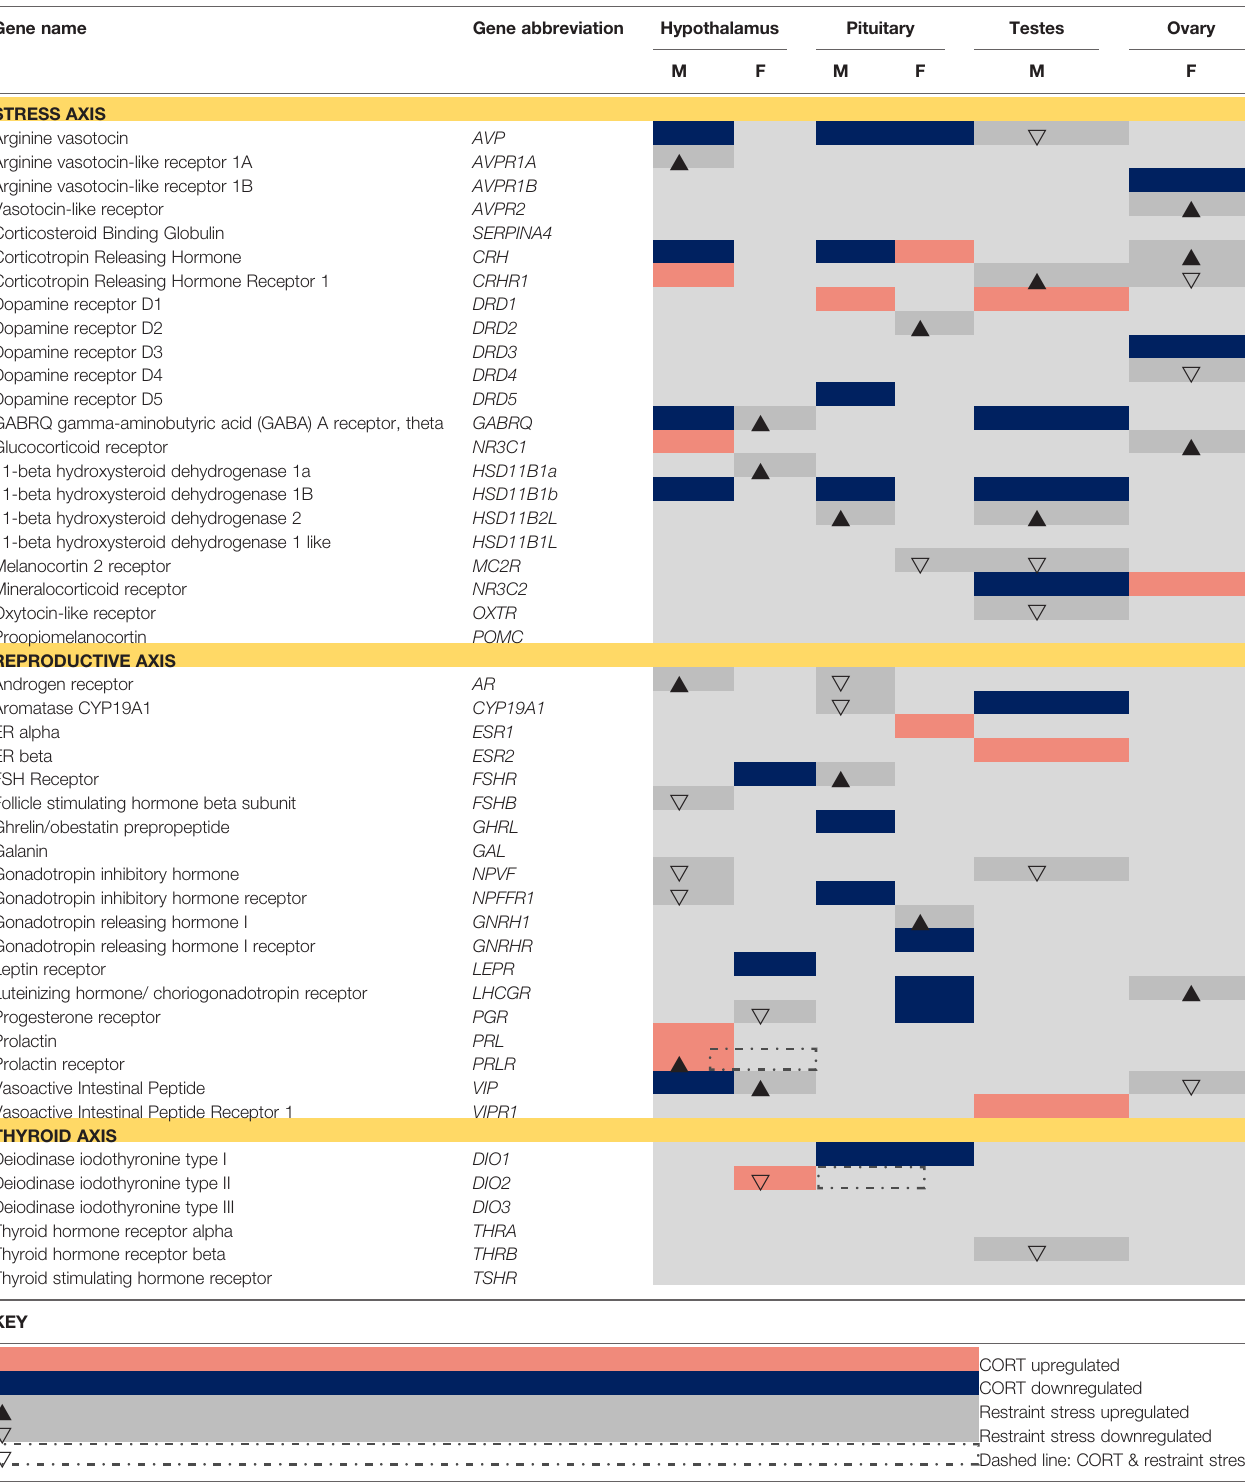
TABLE 1 | A priori -identi fi ed stress and reproduction-associated target genes that differentially express in response to CORT and restraint stress treatments ( a = 0.05).